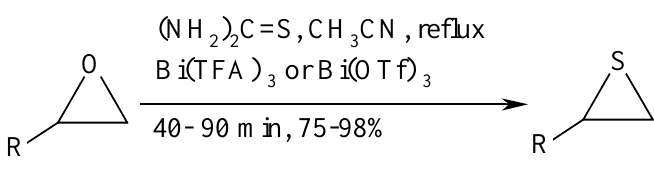
Table 2. Conversion of Epoxides to Thiiranes with (NH